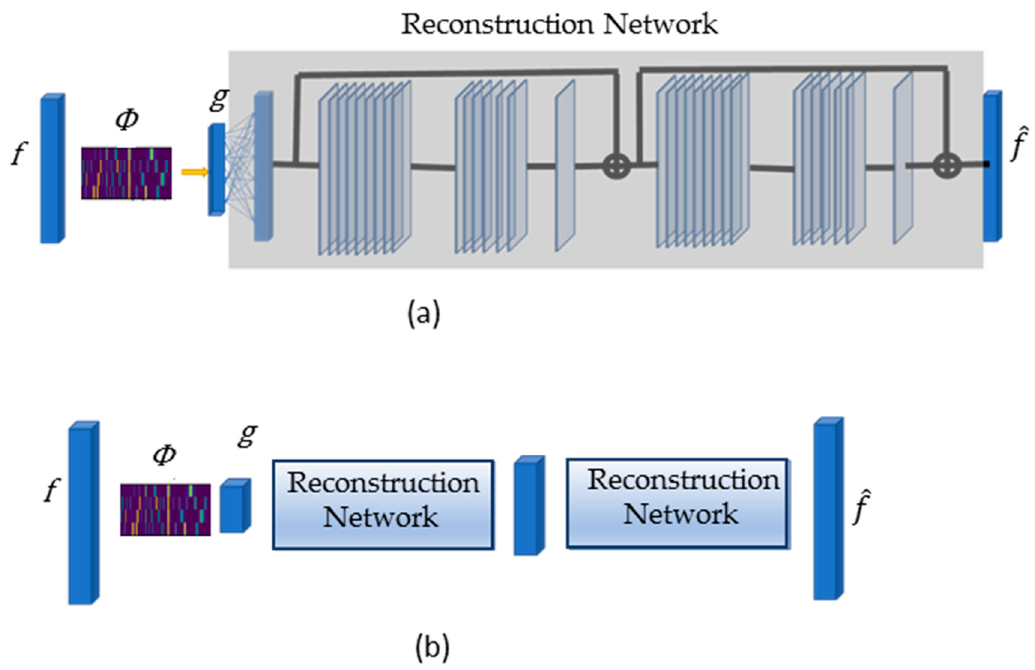
Figure 4. ( a ) A compressed input 𝑔 is obtained by the multiplication of the high-dimensional spectrum 𝑓 with the sensing matrix Φ . The first step in the reconstruction network takes the compressed signal 𝑔 and expands it to the high-dimensional size by a fully connected layer, which learns its coarse approximation. Then, it is refined by a train of residual convolutional blocks, where each block contains 3 convolutional layers. The first layer has 64 kernels of size 9, the second has 32 kernels of size 1, and the third has 1 kernel of size 7. The number of residual blocks is a hyperparameter of the system. ( b ) A progressive reconstruction network upsamples the signal to intermediate size and upsamples it again using a sequence of reconstruction network blocks as shown in ( a ). The number of subnetworks is a hyperparameter of the system. 2.6. Loss Function and Metrics for the PyCAE We use the mean-square-error (MSE) as the loss function of the PyCAE to reduce the differences between sample pairs (input–label) from the training set in the training phase. The MSE is defined as follows: 𝑀𝑆𝐸(cid:3435)𝑓(cid:4632), 𝑓(cid:3439) = 1 𝑛 (cid:3533)(cid:3630)𝑓(cid:4632) (cid:3036) − 𝑓 (cid:3036) (cid:3630) (cid:2870)(cid:3041) (cid:3036)(cid:2880)(cid:2869) (12) where 𝑛 is the number of spectral bands in the signal 𝑓 ∈ ℝ (cid:3015) (cid:3338) , and 𝑓(cid:4632) ∈ ℝ (cid:3015) (cid:3338) is the estimation of signal 𝑓 . To evaluate the reconstruction performance, we use two widely used metrics: (1) Structural similarity index measure (SSIM) [45] to assess the similarity between the structure of the estimated signal to the label as follows: